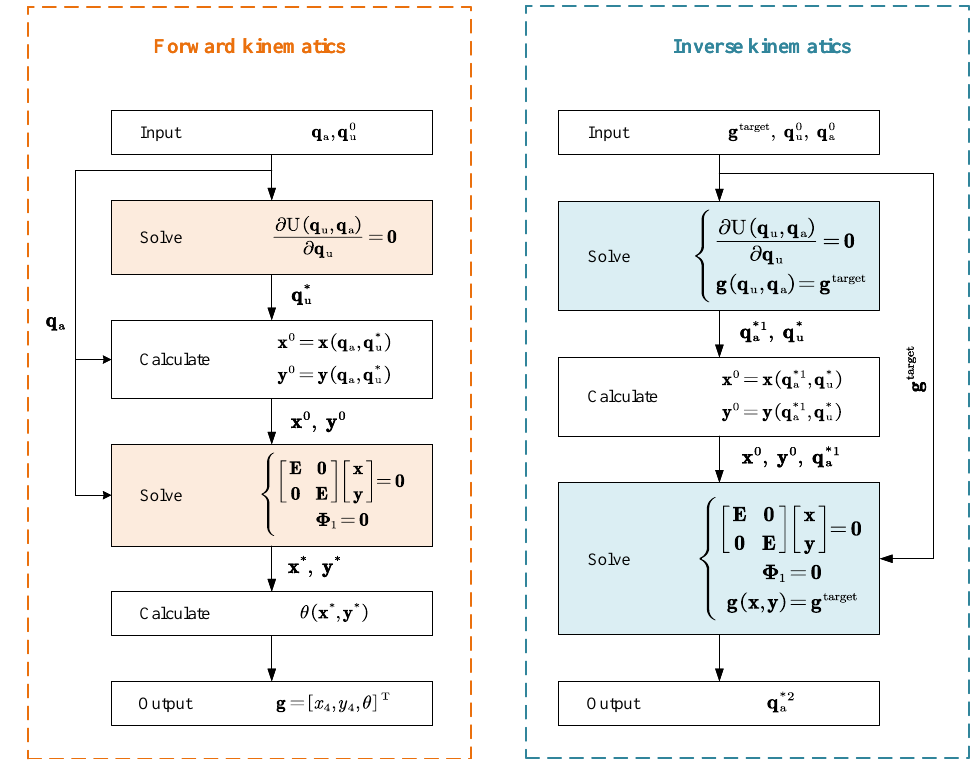
Figure 4. Kinematics solving